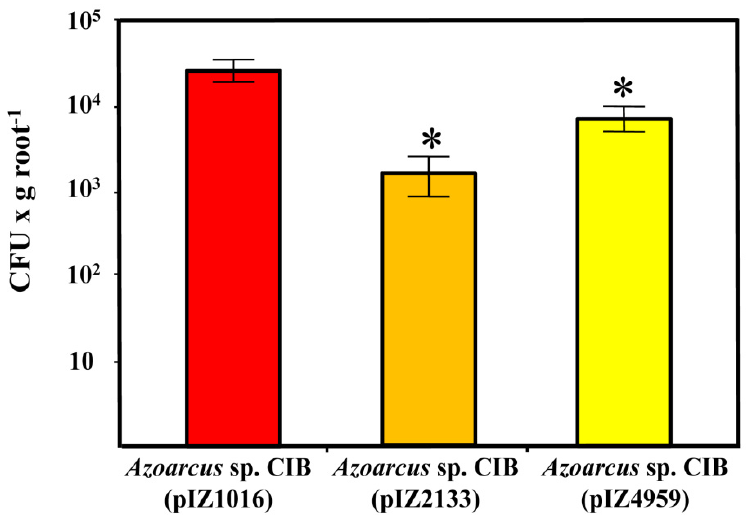
Figure 5. Rice roots colonization by Azoarcus sp. CIB strains producing different levels of c-di-GMP. Rice seedlings were inoculated with Azoarcus sp. CIB (pIZ1016) (empty plasmid), Azoarcus sp. CIB (pIZ2133) (expressing the PA2133 phosphodiesterase) and Azoarcus sp. CIB (pIZ4959) (expressing the PP4959 diguanylate cyclase). Plants were grown at 25 °C for 5 days and bacteria present inside the roots were determined as described in Methods. The graph shows the CFU values per gram of root (fresh weight) of three independent experiments; error bars represent the standard deviation. Values of Azoarcus sp. CIB (pIZ1016) versus Azoarcus sp. CIB (pIZ2133) ( p = 0.0142) and Azoarcus sp. CIB (pIZ4959) ( p = 0.0154) were significantly different from each other and are indicated with one asterisk (paired t -test analysis).